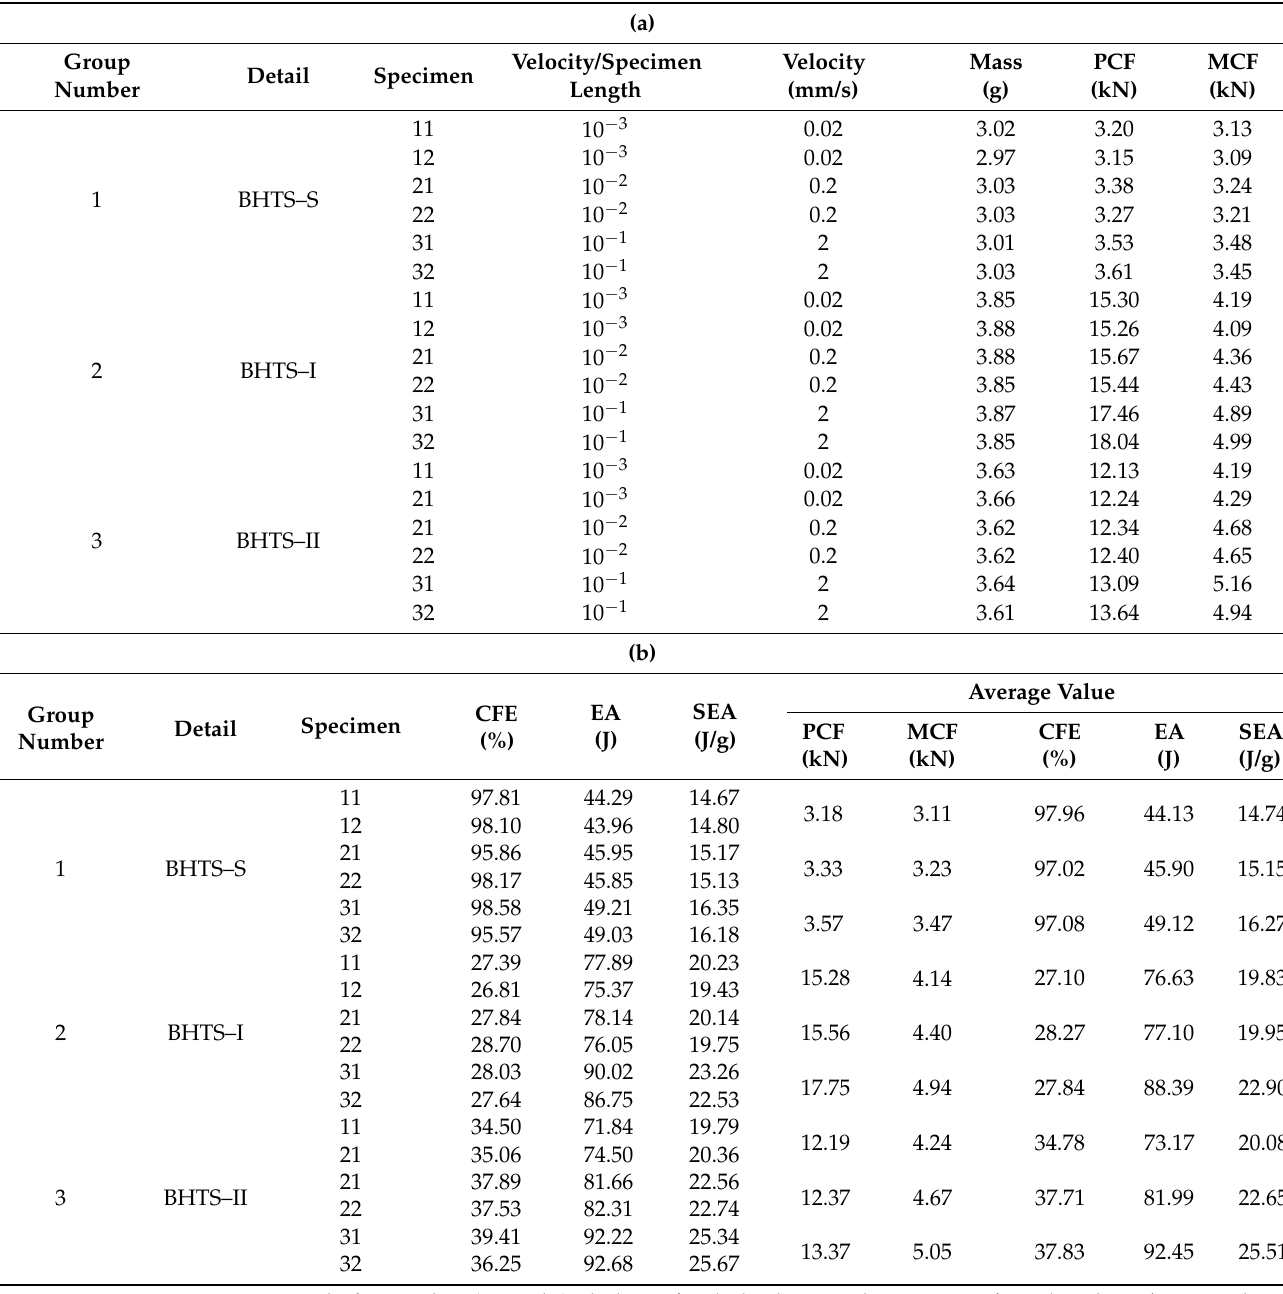
Table 5. Values of each EA property of BHTS under different strain